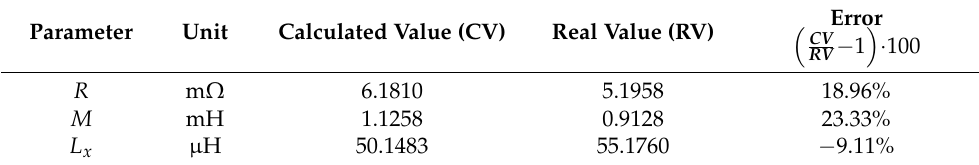
Table 3. The experimental results with two sinusoidal voltage test signals and estimated voltage.